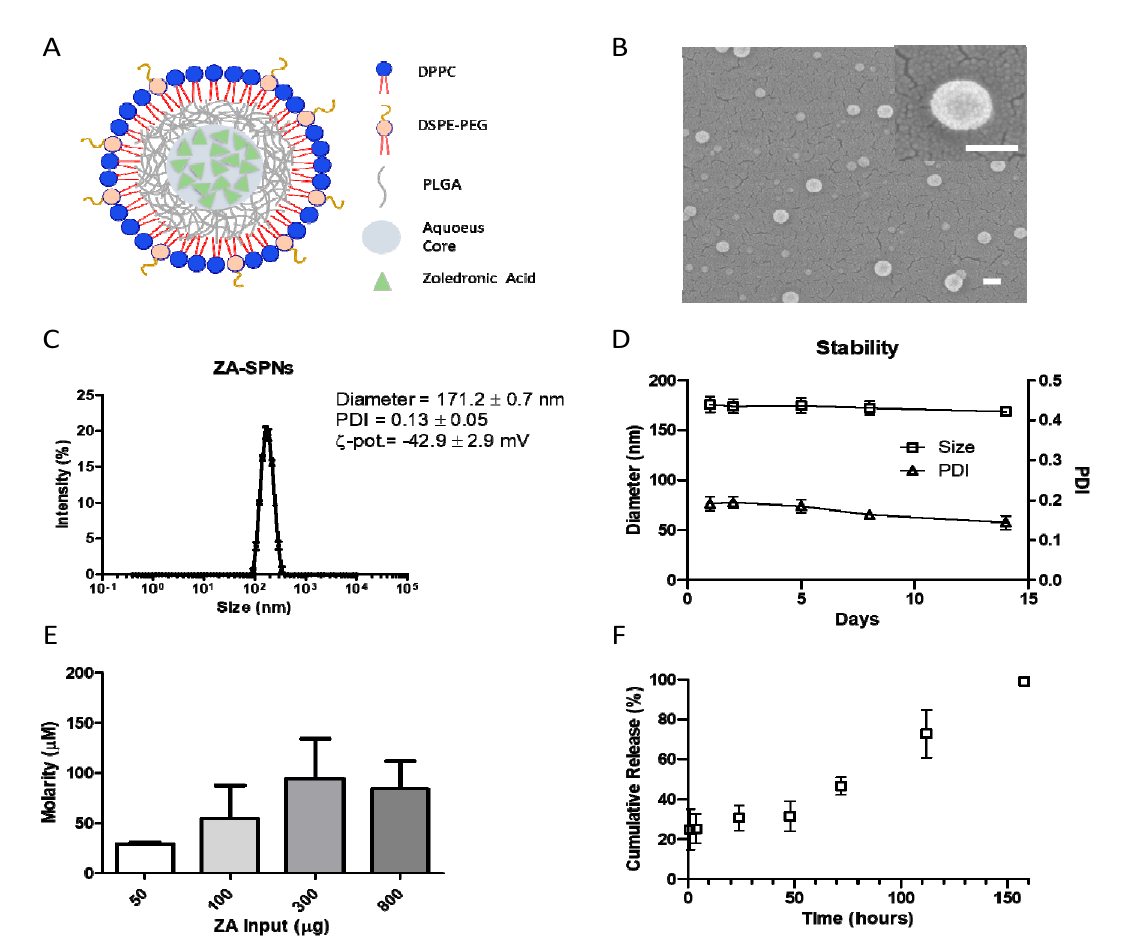
Figure 1. Zoledronic acid–spherical polymeric nanoparticles’ (ZA-SPNs) physico-chemical properties. ( A ) Schematic of a ZA-SPN. DPPC: 1,2-dipalmitoyl-sn-glycero-3-phosphocholine; DSPE-PEG: 1,2-distearoyl-sn-glycero-3-phosphoethanolamine-N-[succinyl(polyethylene glycol)-2000]; PLGA: Poly(D,L-lactide-co-glycolic) acid. ( B ) SEM images of ZA-SPNs, showing their spherical shape and dimension (enlargement in the upper-right corner). Scale bar: 100 nm. ( C ) Size distribution of ZA-SPNs; polydispersity index (PDI) and ζ -potential values are also shown. ( D ) Size and PDI stability over time of ZA-SPNs. ( E ) ZA-SPNs batch average molarity ( µ M) obtained for di ff erent input amounts of ZA in the synthesis process, showing 300 µ g as the best input condition. ( F ) Release profile of ZA from ZA-SPNs, showing the minimal ZA loss within the first 48 h. Panels C–F: mean values ±